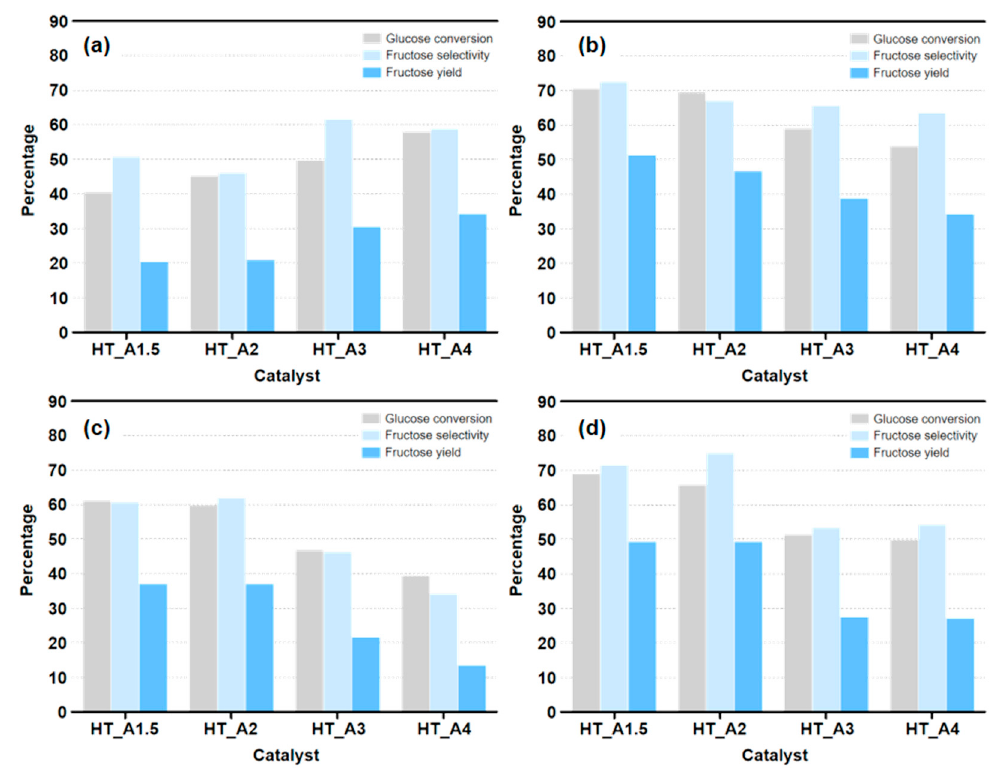
Figure 5. Catalytic activities of HTX catalysts (X = 1.5, 2, 3, and 4) in the glucose isomerization. Catalytic activities measured in ( a ) water, ( b ) MeOH, ( c ) DMSO, and ( d ) DMF.